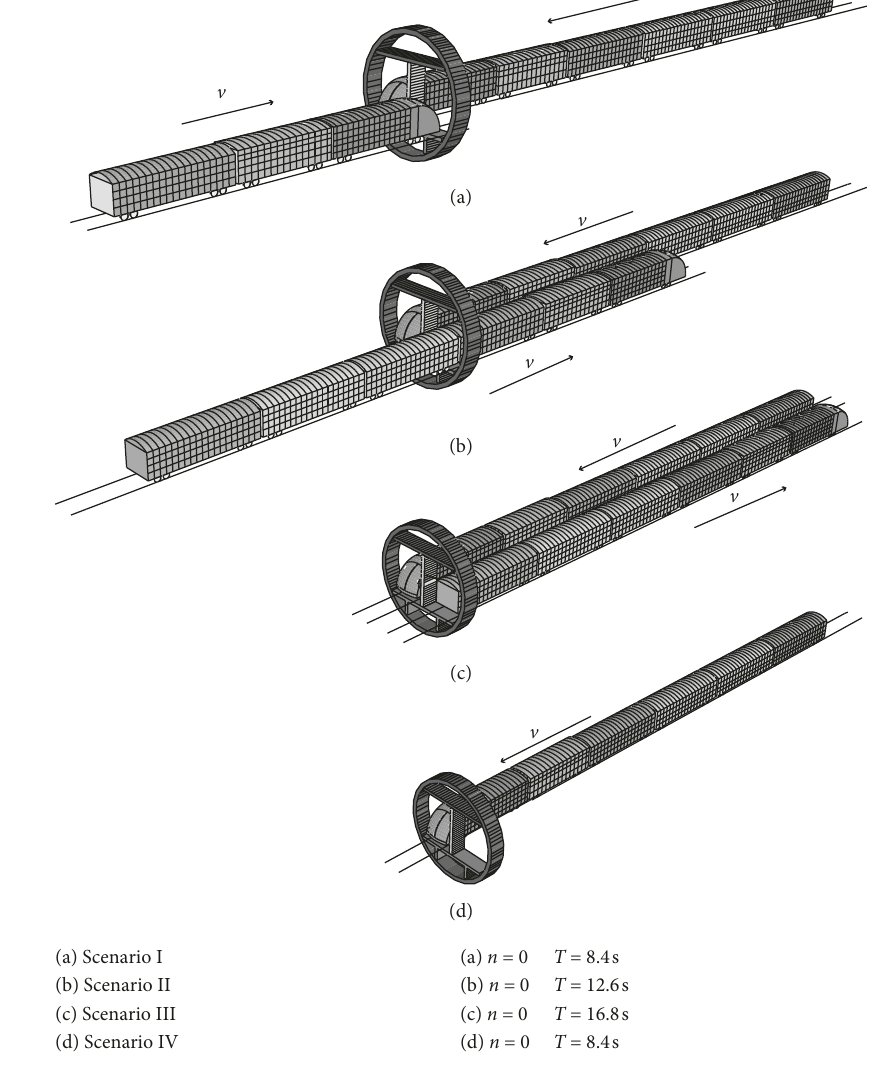
Figure 4: Four typical train-meeting scenarios.